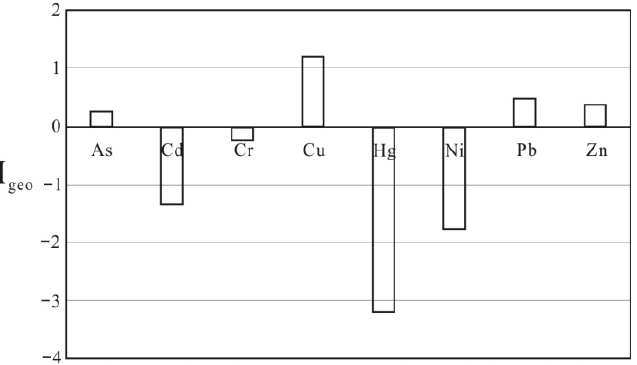
Figure 3. Histogram of the average geoaccumulation indices of heavy metals.